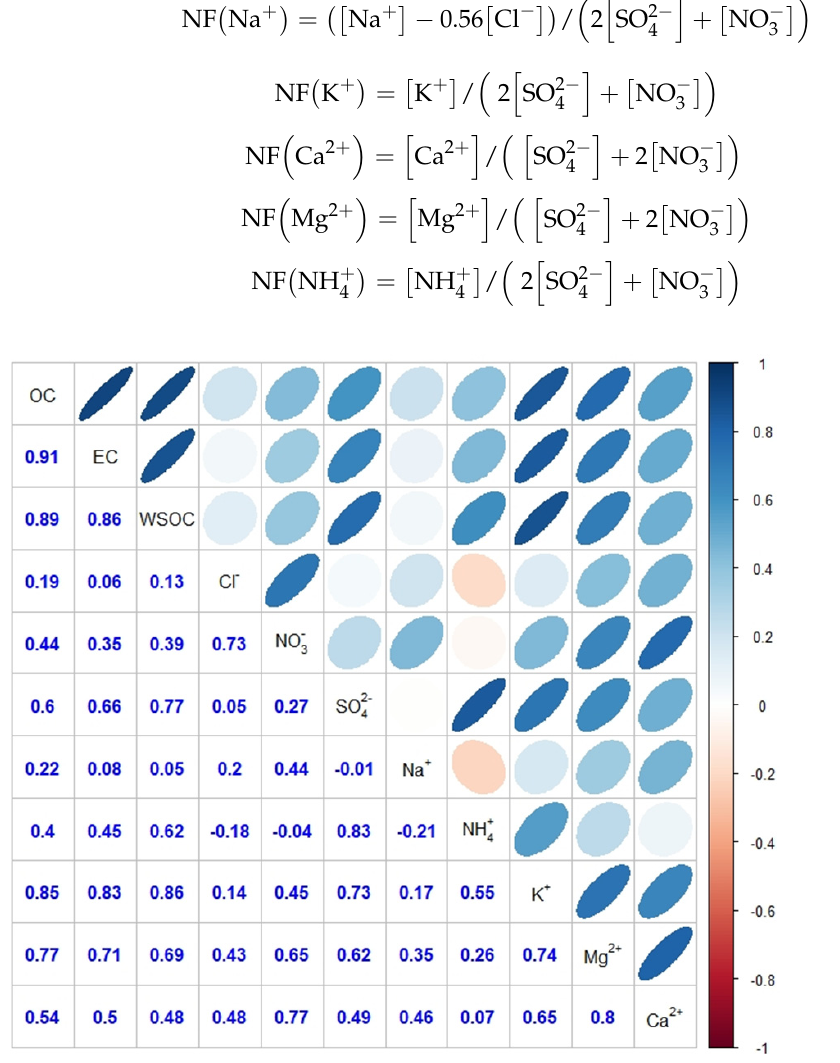
Figure 2. Correlation between measured chemical species over Manora Peak, Nainital.